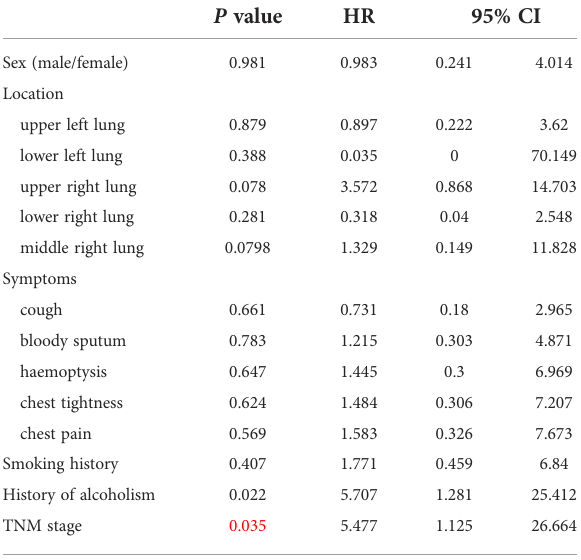
TABLE 2 Univariate survival analysis of patients with pulmonary mucoepidermoid carcinoma. P